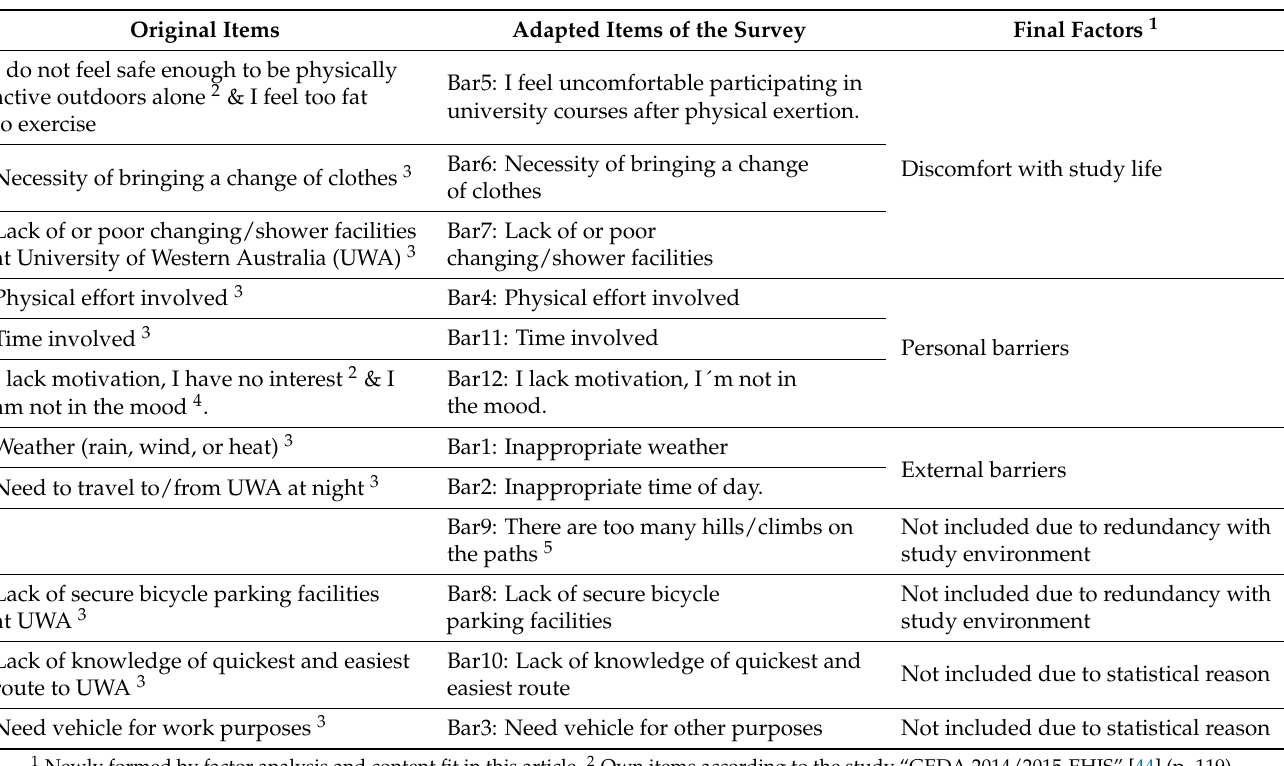
Table A3. Comparison of the final construct of barrier items newly formed by the factor analysis and content fit in this article. Original